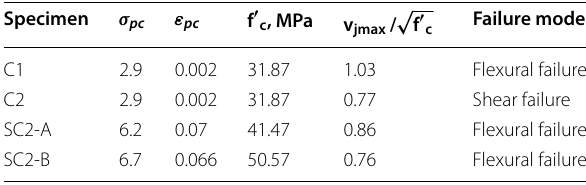
Table 9 Summary of experimental